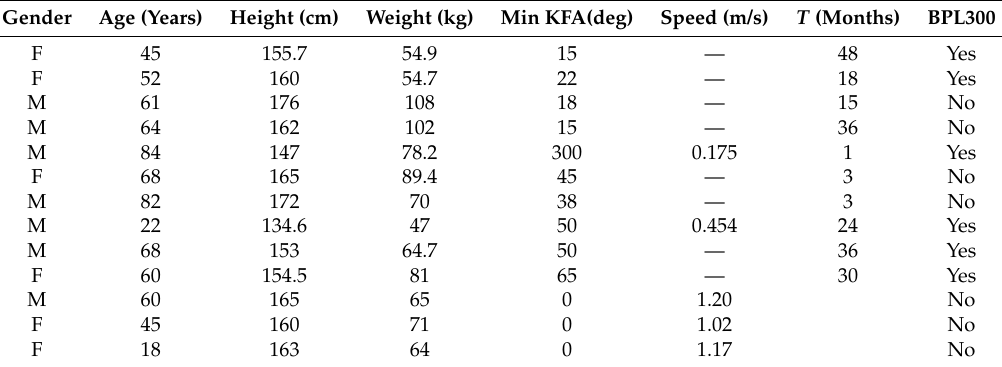
Figure 10. Measure Dorsal Plantar Flexion range for the leg [21]. Table 2. Characteristics for sick and healthy subjects collected for the